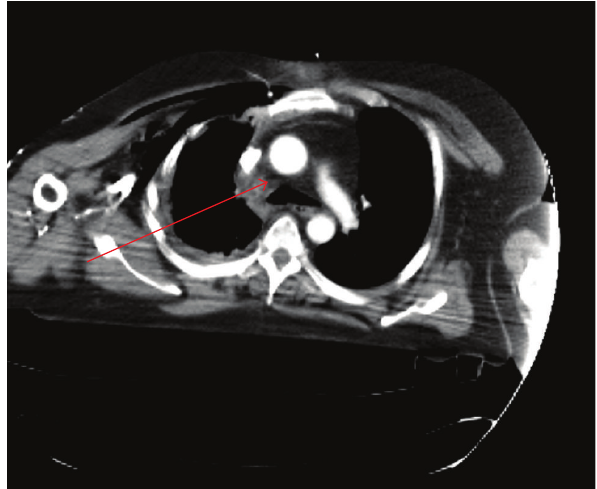
Figure 2: CT Thorax with a right-sided paratracheal haematoma at the level of the azygous vein (see arrow).